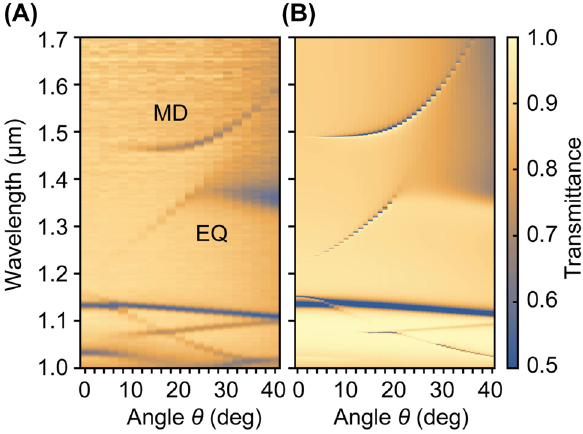
Figure 3: Angle-resolved transmittance measurements. (A) Transmittance spectra obtained by experiment and (B) FDTD simulation. In both cases, s -polarized light with a wave vector along the y direction was used to couple light into the metasurface without broken symmetry ( s / L = 0%). normal incidence ( 𝜃 = 0 ◦ ), and the two quasi-BIC modes are decoupled from the incident plane wave due to the symme- try mismatch. Breaking the symmetry by deviating 𝜃